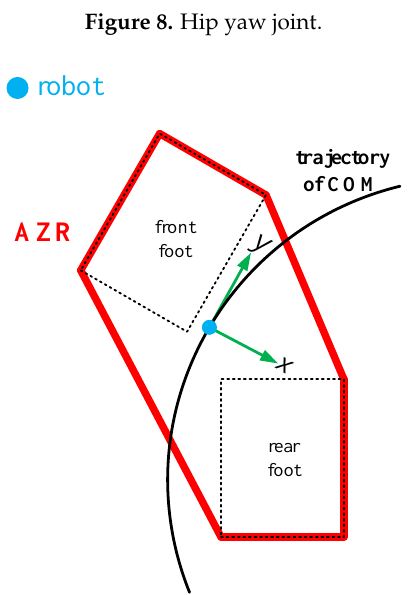
Figure 8. Hip yaw joint.